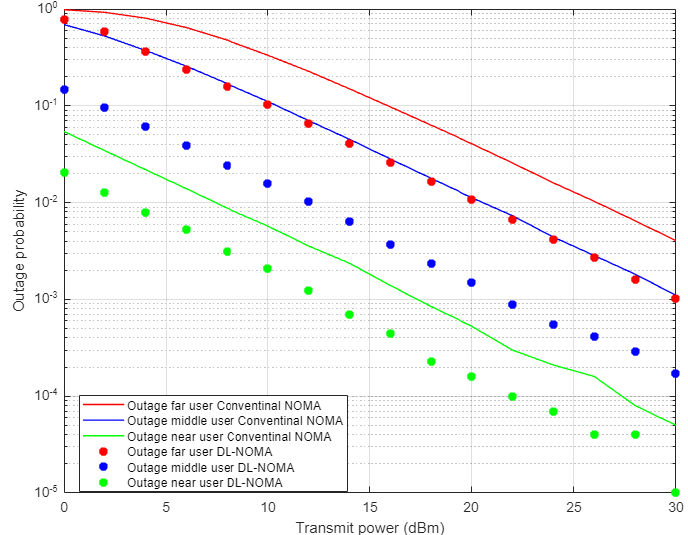
Figure 5. Outage probability vs. power-based DL and conventional NOMA (Rayleigh Channel).